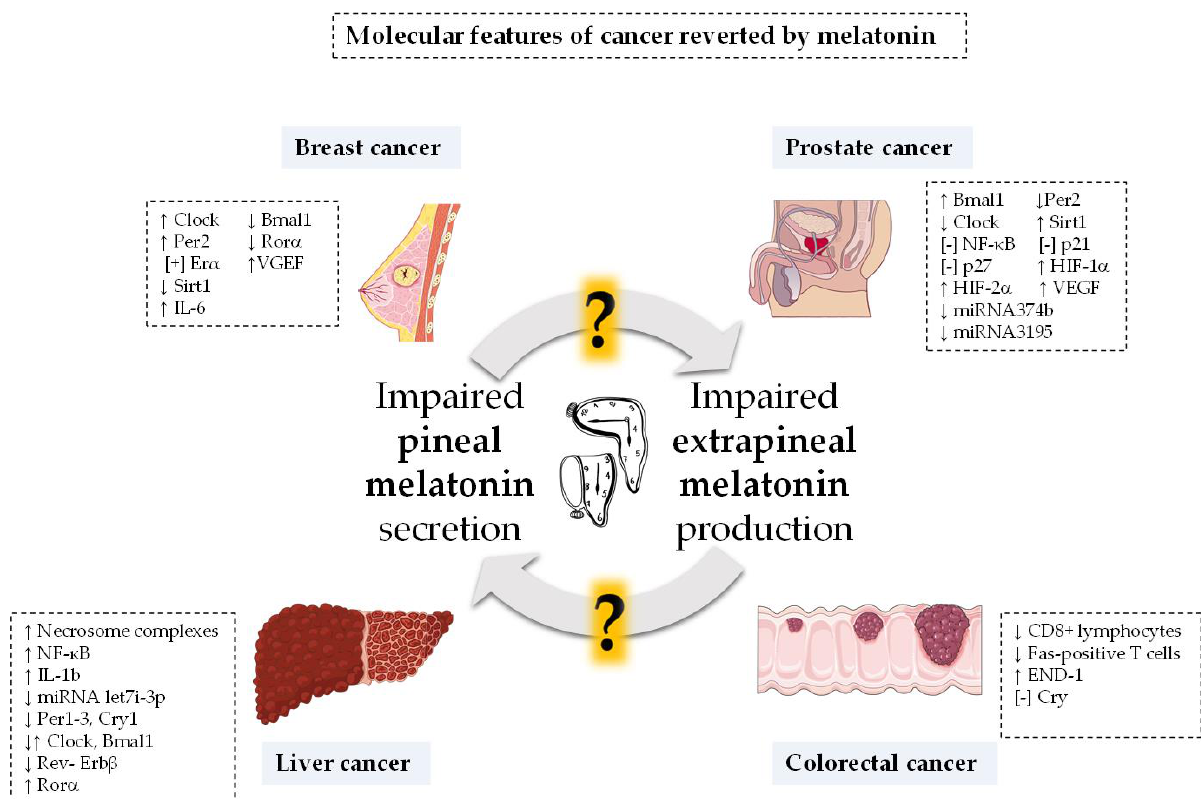
Figure 3. Schematic view of the possible dysregulation between pineal and extrapineal melatonin and the tumor molecular features reverted by the indolamine in breast, prostate, liver and colorectal cancer. The symbols stand for: ↑ upregulation or increment, ↓ downregulation, [+] activation, and [−] inhibition. This figure was built with SMART resources (Servier Medical Art), licensed under a Creative Common Attribution 3.0 Generic License. See http://smart.servier.com/. Prostate cancer image was extracted from Prostate Center Europe website : https://www.prostatecentereurope.com/disorders/pros- tate-cancer